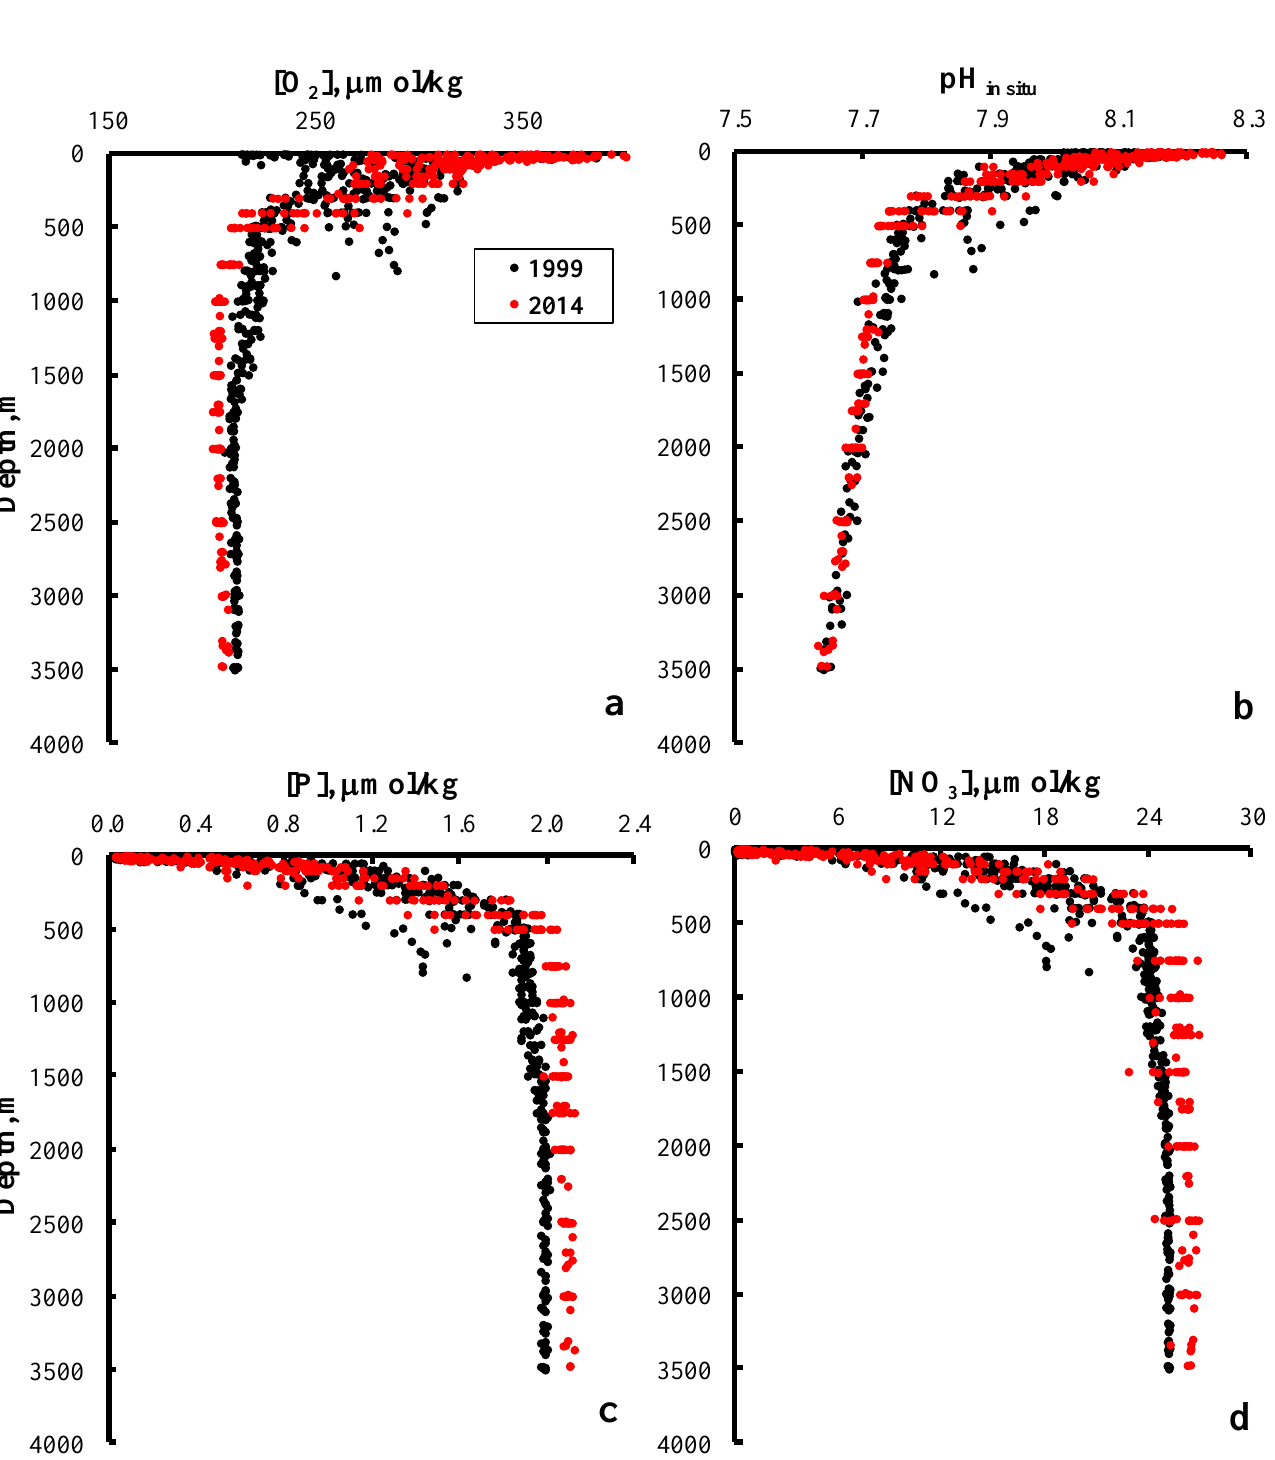
Figure 11. Vertical profiles of measured hydrochemical parameters in the northwestern part of the JES in 1999 (black circles) and 2014 (red circles). ( a ) DO (µmol/kg); ( b ) pH in situ ; ( c ) phosphorus concentration (µmol/kg); ( d ) nitrate concentration (µmol/kg).